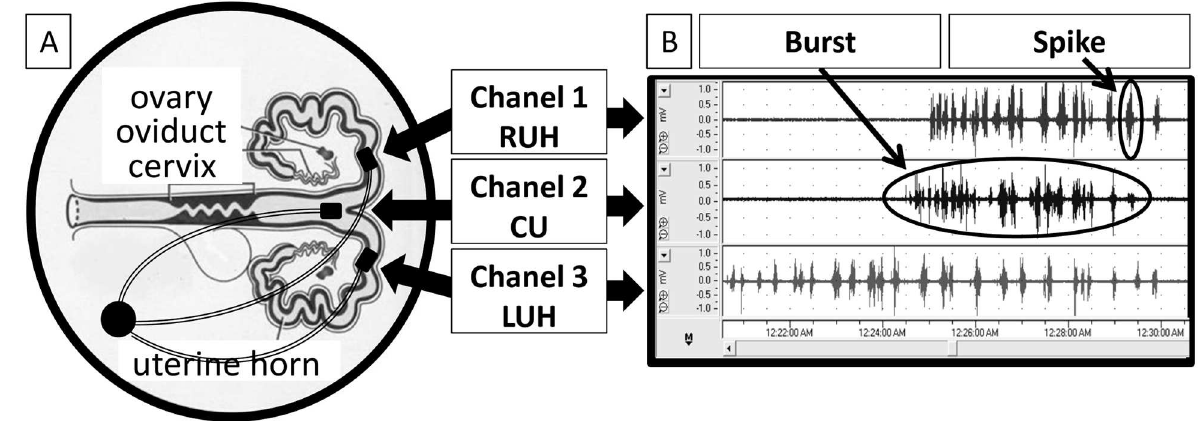
Fig 1. Diagram of the measurement system. Electrodes were arrangedin the porcine reproductive tract (A) and the EMG signals(B) were sampledfrom: channel1, right uterine horn, RUH; channel2, corpus uteri, CU; and channel3, left uterine horn, LUH.